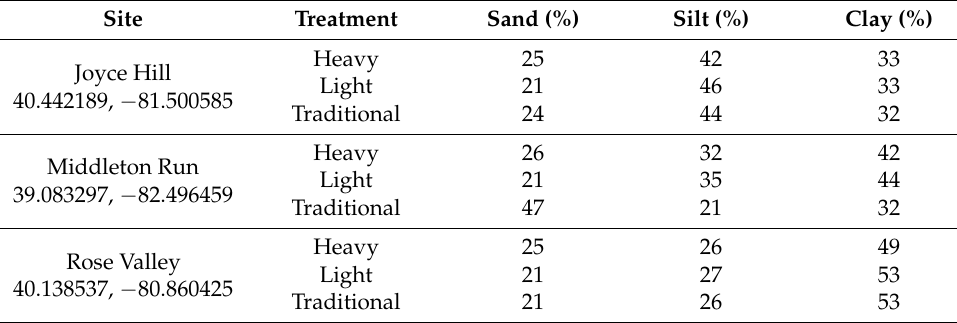
Table 1. Site location, treatments, and soil texture, 0–15